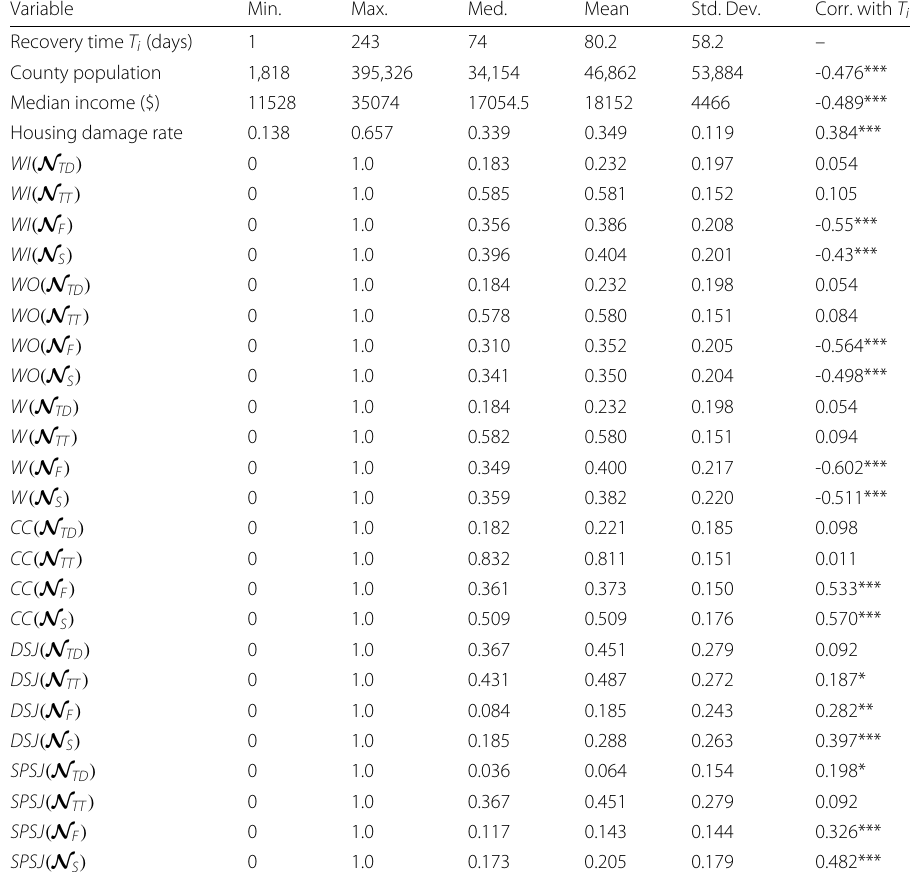
Table 5 Statistics of independent and objective